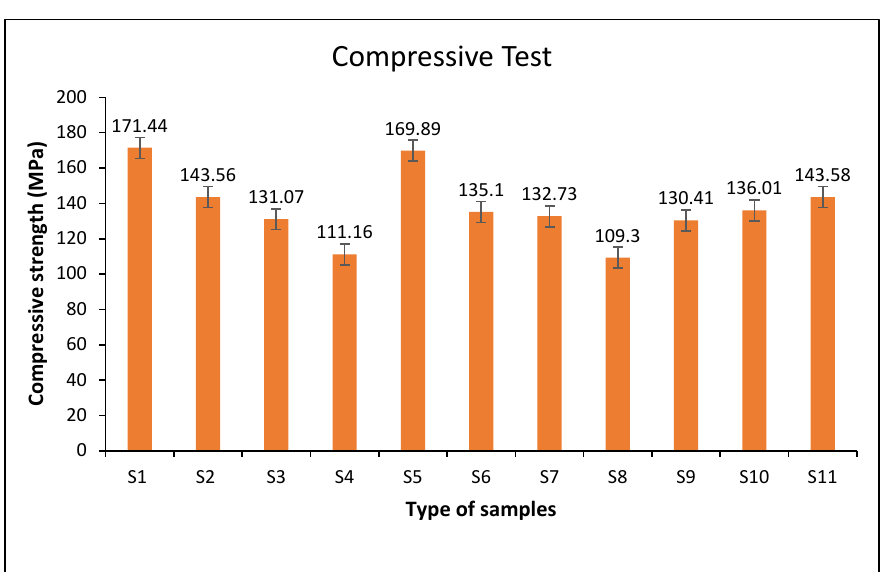
Figure 4. The compressive strength of recycled hybrid materials with reinforced B 4 C and ZrO 2 par- ticles.